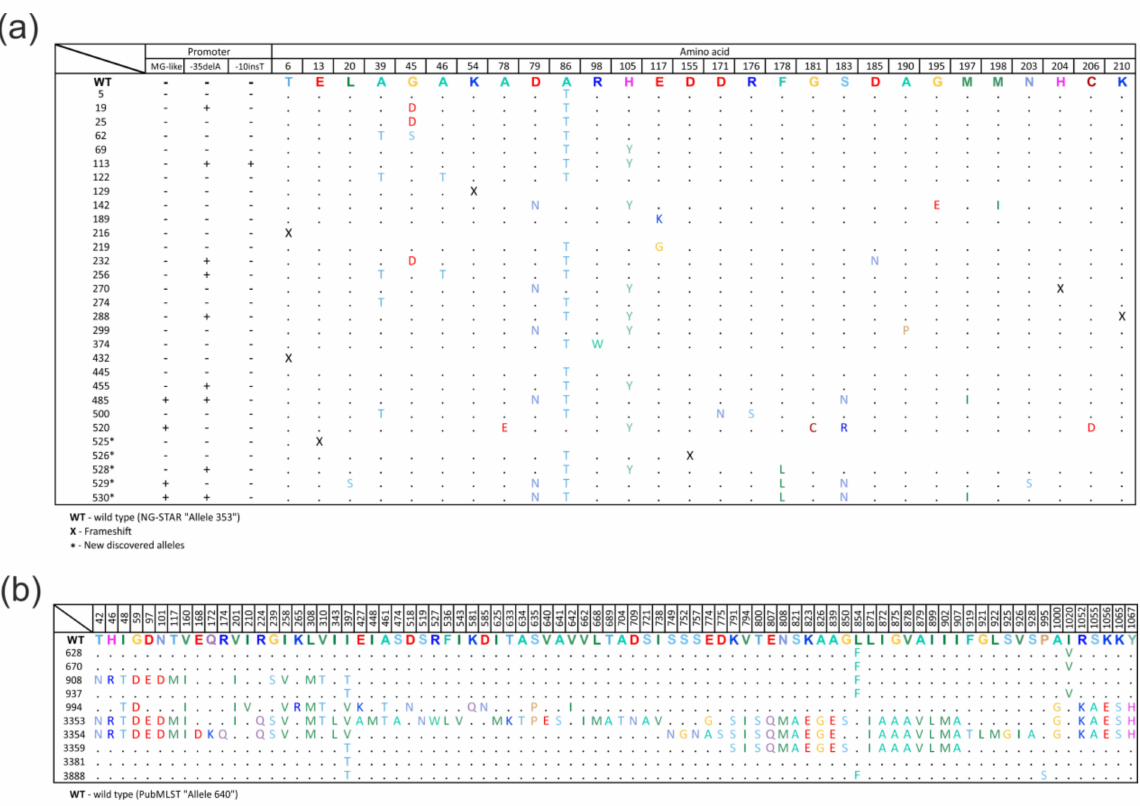
Figure 1. Amino acid sequences of mtrR ( a ) and mtrD ( b ) alleles in N. gonorrhoeae isolates collected in the Russian Federation in 2020–2021 in comparison with the wild type (WT) mtrR (NG-STAR “Allele 353”) and mtrD (PubMLST “Allele 640”) sequences. Designations: ‘+’ – presence of deletion/ MG-like promoter; ‘–‘ – absence of deletion/ MG-like